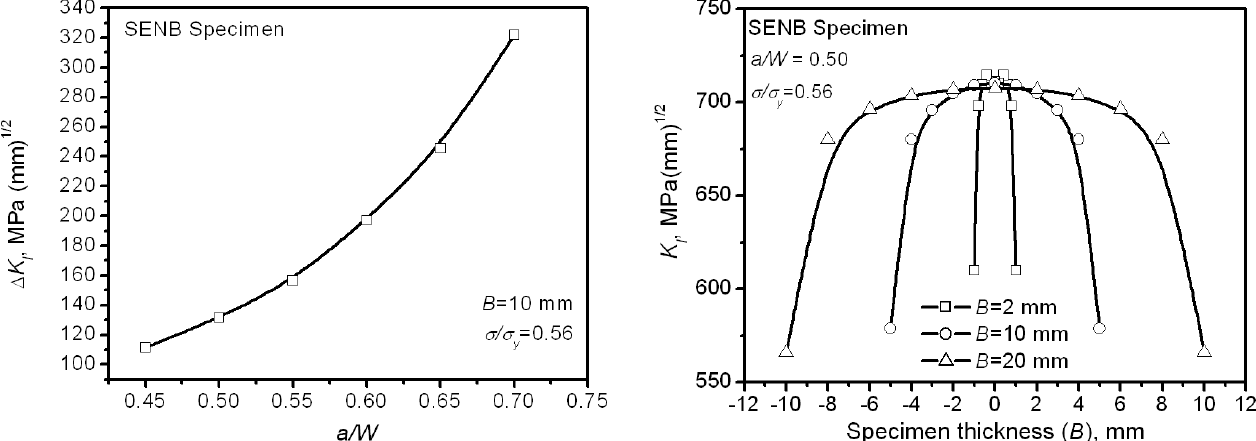
Figure 6: Variation of  K for various a/W ratios. Figure 7: Variation of K I along the crack-front for B =2 mm, 10 I mm and 20 mm with a/W